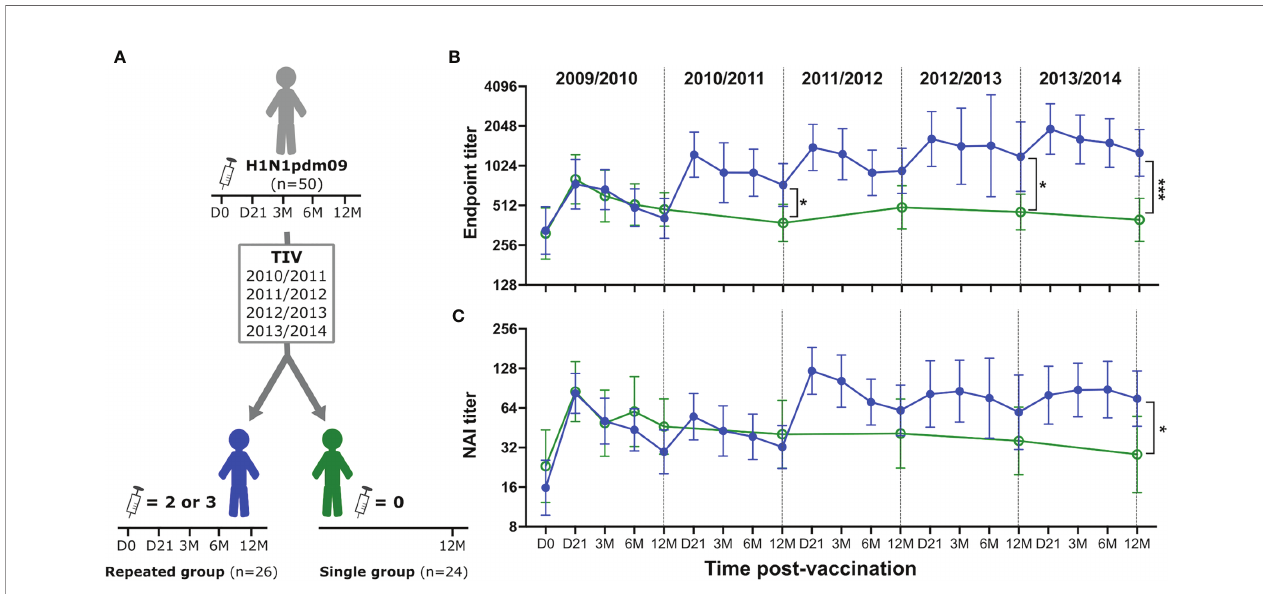
FIGURE 2 | H1N1pdm09 vaccination induced durable NA-speci fi c antibody responses boosted by trivalent in fl uenza vaccines. Study design (A) . Health care workers were divided into two groups based on their vaccination status after H1N1pdm09 vaccination in 2009. The repeated group (blue, fi lled circles) received two or three trivalent in fl uenza vaccines (TIV) during seasons 2010/2011-2013/2014. Blood samples were collected 21 days (D21), and 3, 6, 12 months (3M, 6M, 12M, respectively) after vaccination. The single group (green, open circles) chose not to be further vaccinated but provided yearly blood samples prior to the start of each season (12M). NA-speci fi c antibody responses were measured by ELISA (B) and ELLA (C) during each in fl uenza season from 2009/2010 to 2013/2014. Data are shown as geometric mean with 95% con fi dence intervals. Analyzes of statistical difference between the single and repeated group was done by non-parametric Kruskal-Wallis test in GraphPad Prism 9. *P ≤ 0.05, ***P ≤